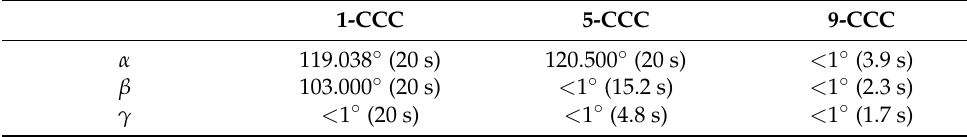
Table 1. Wettability of the CCC with different treatment